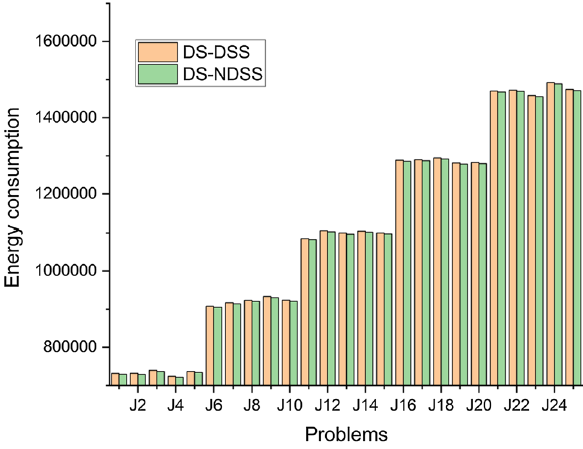
Fig. 12 The average energy consumption of DS-DSS and DS-NDSS